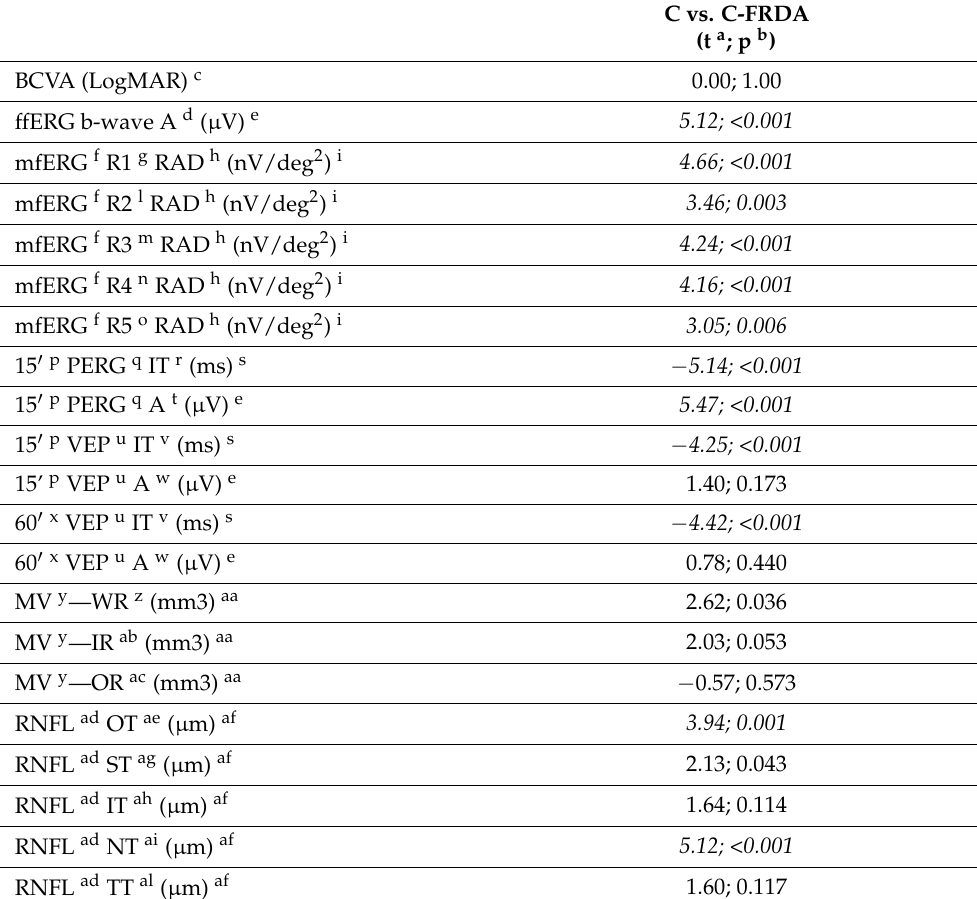
Table 2. Inferential statistics of the functional and morphological retinal and optic nerve values between carriers of Friedreich’s ataxia (C-FRDA) eyes and Control eyes (C).